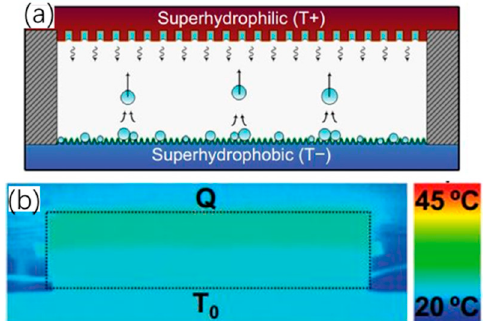
Figure 6. Schematic of the planar phase-change jumping-drop thermal diode. ( a ) Forward mode with self-propelled jumping droplets from the superhydrophobic condenser to the superhydrophilic evaporator, and ( b ) infrared imaging of the diode at steady-state in forward mode. Reproduced with permission from [61]; published by AIP publishing, 2011.